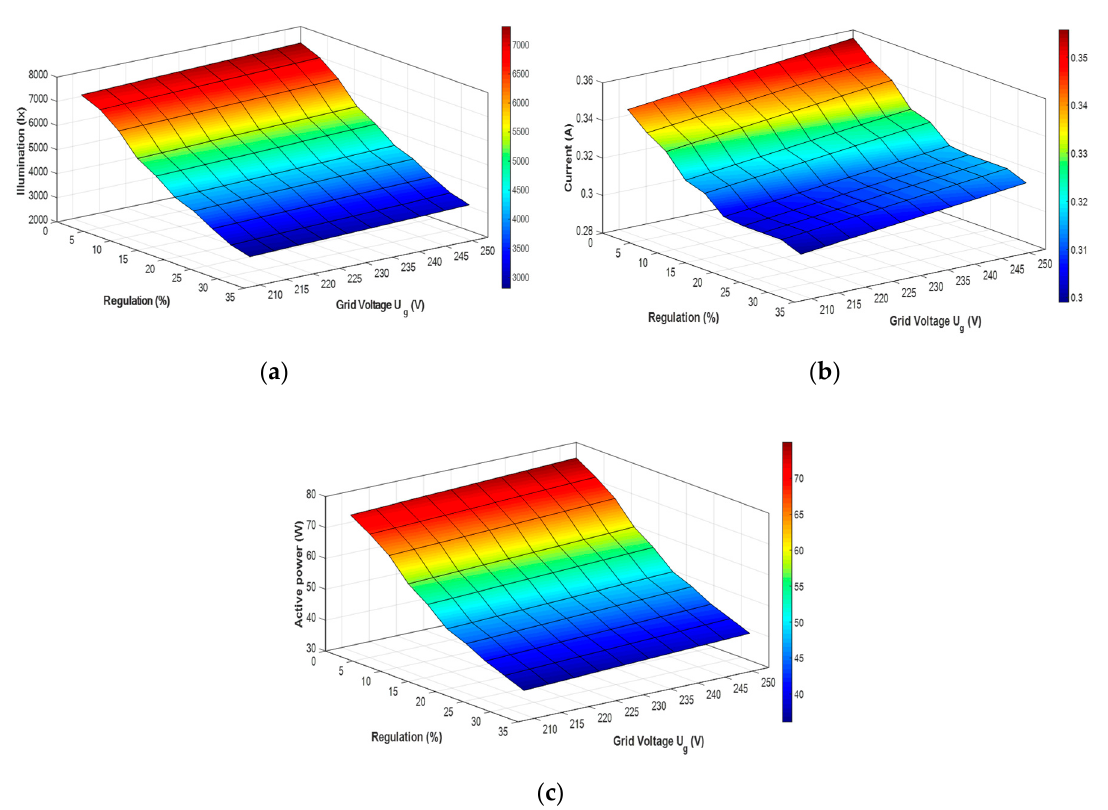
Figure 13. CDO Lamp regulation: ( a ) Illumination; ( b ) Current; ( c ) Active power.